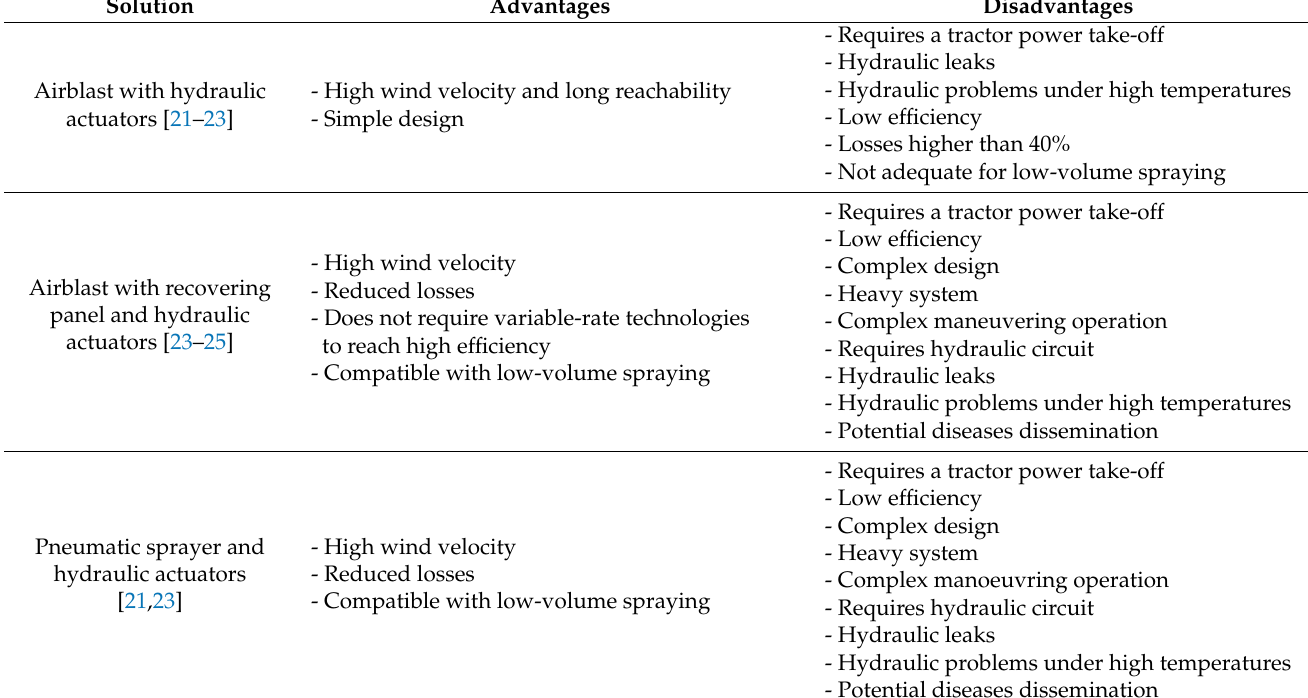
Table 1. Sprayer design approaches